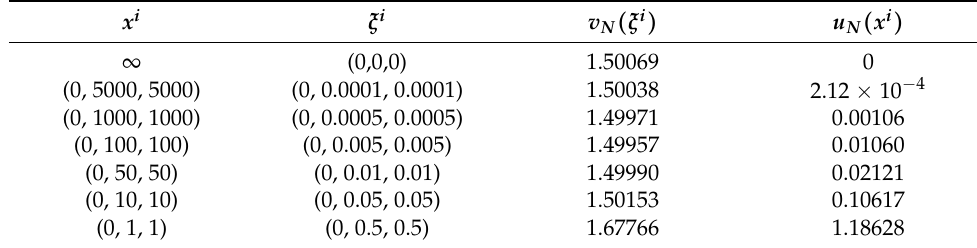
Table 3. Results for Problem 1 (in Example